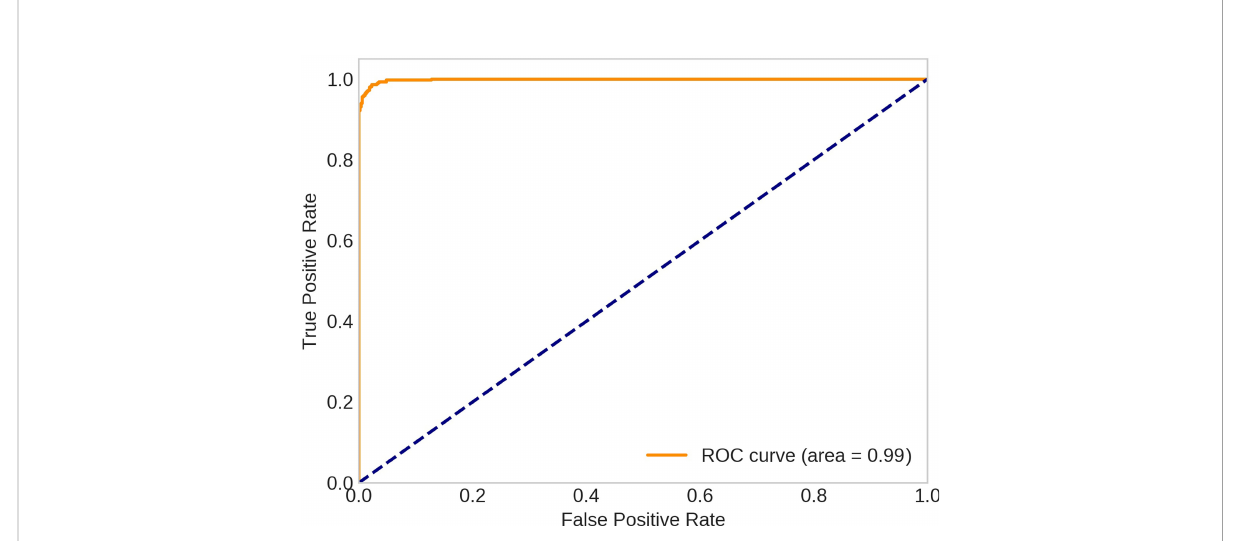
FIGURE 6 ROC curves for VGG-16 with attention model (trained on the fi rst fold of the dataset and tested on the second fold).